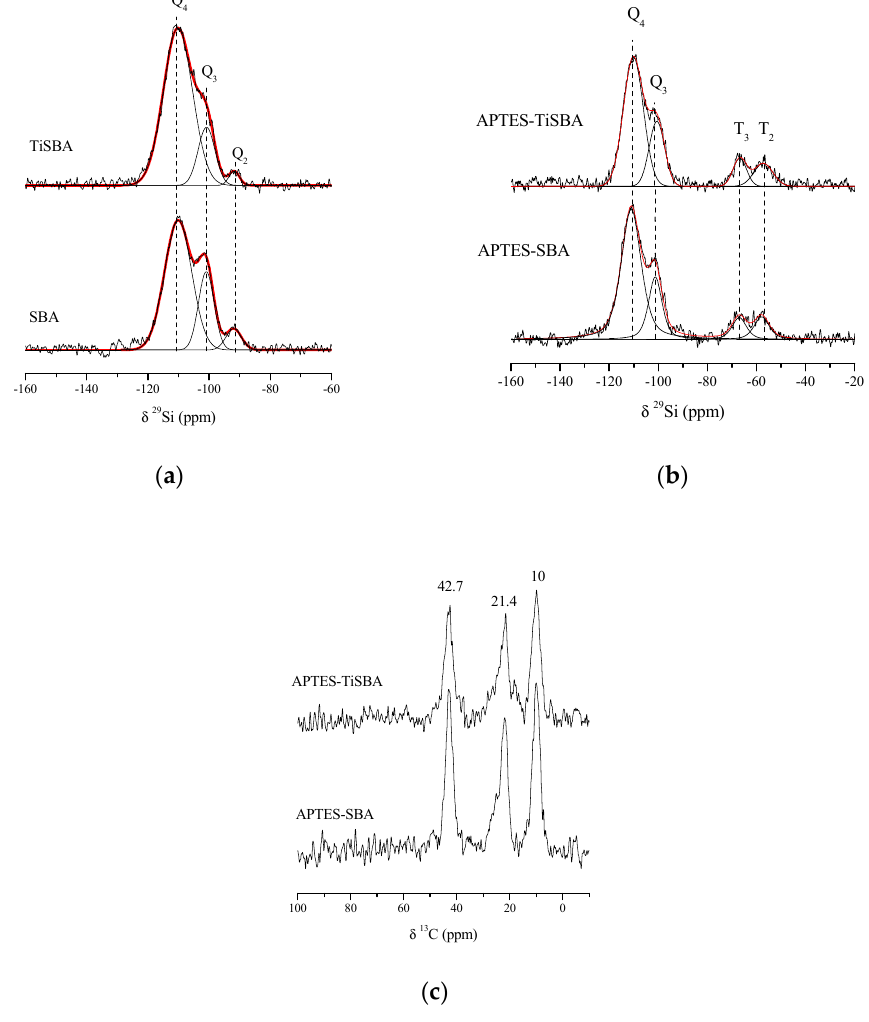
Table 2. 29 Si NMR band position and its contribution. SBA APTES_SBA Ti-SBA